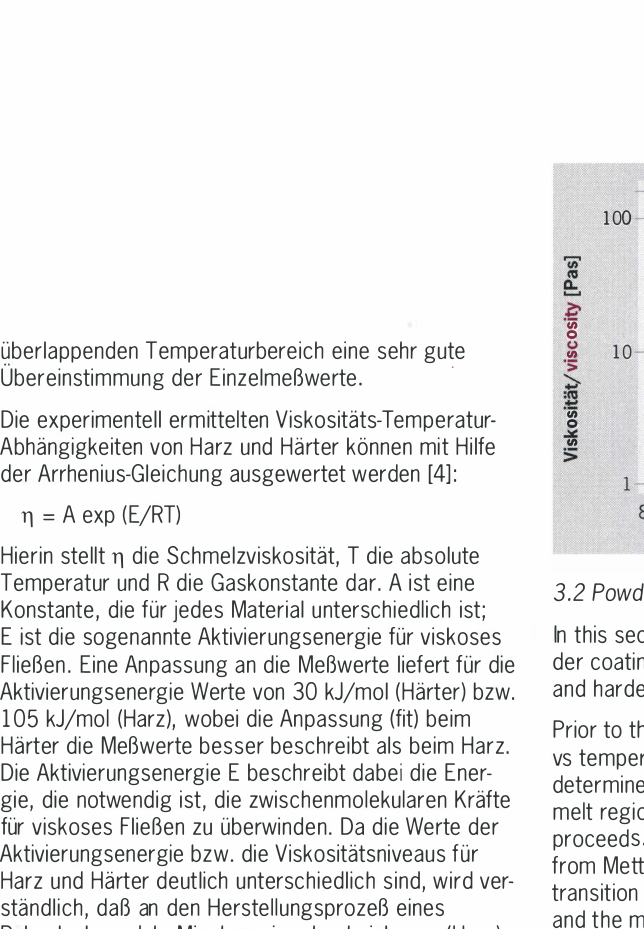
Fig. 4: Viscosity as a function of temperature for powder coa­ ting A subjected to various heating